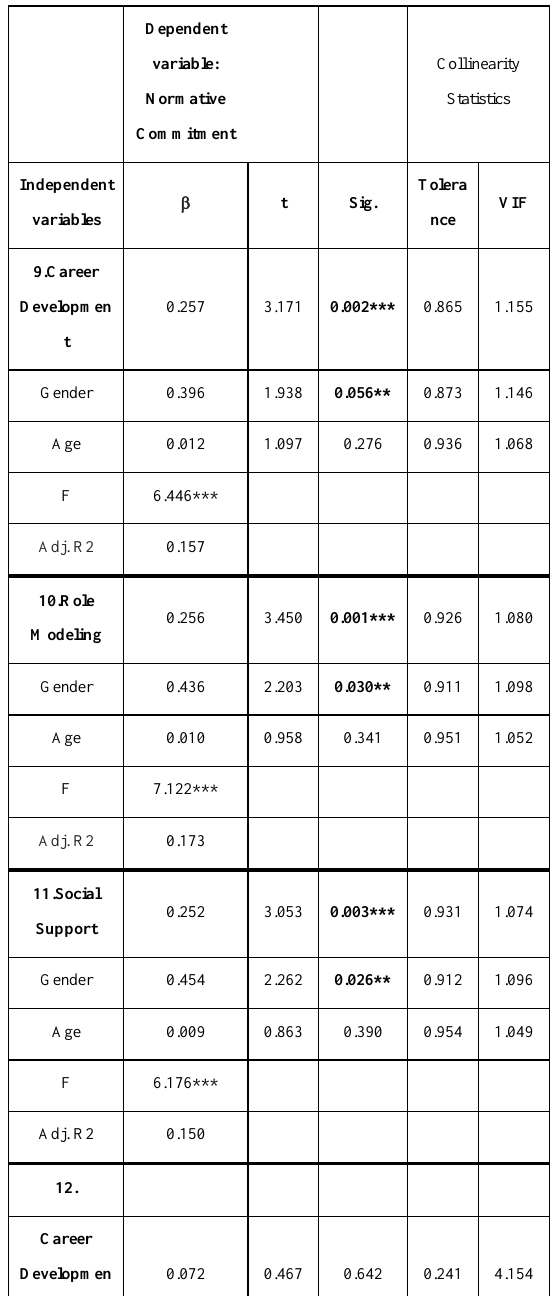
Table 8.The Effect of Mentoring on